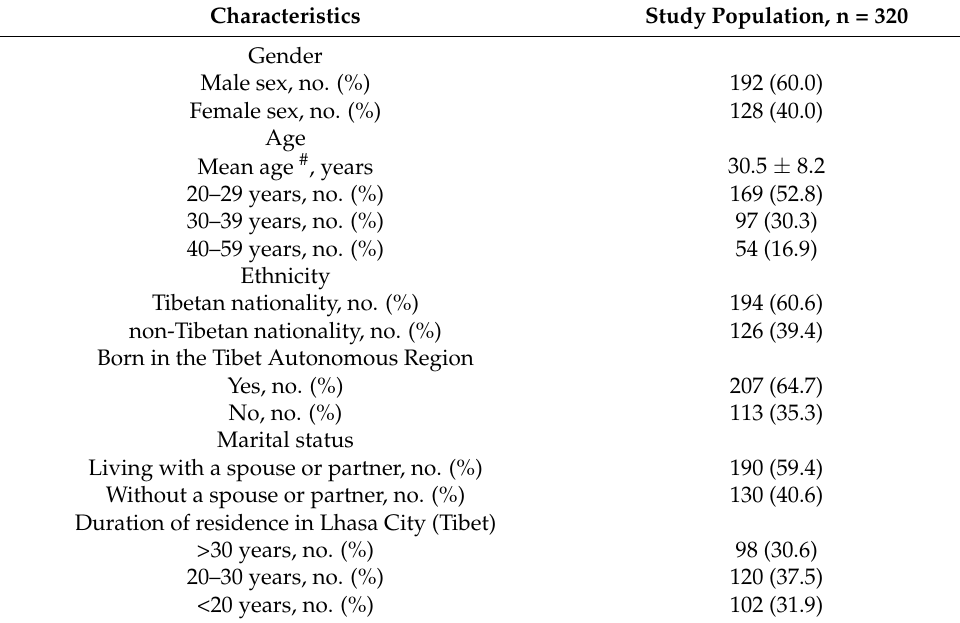
Table 1. Demographic characteristics of the study